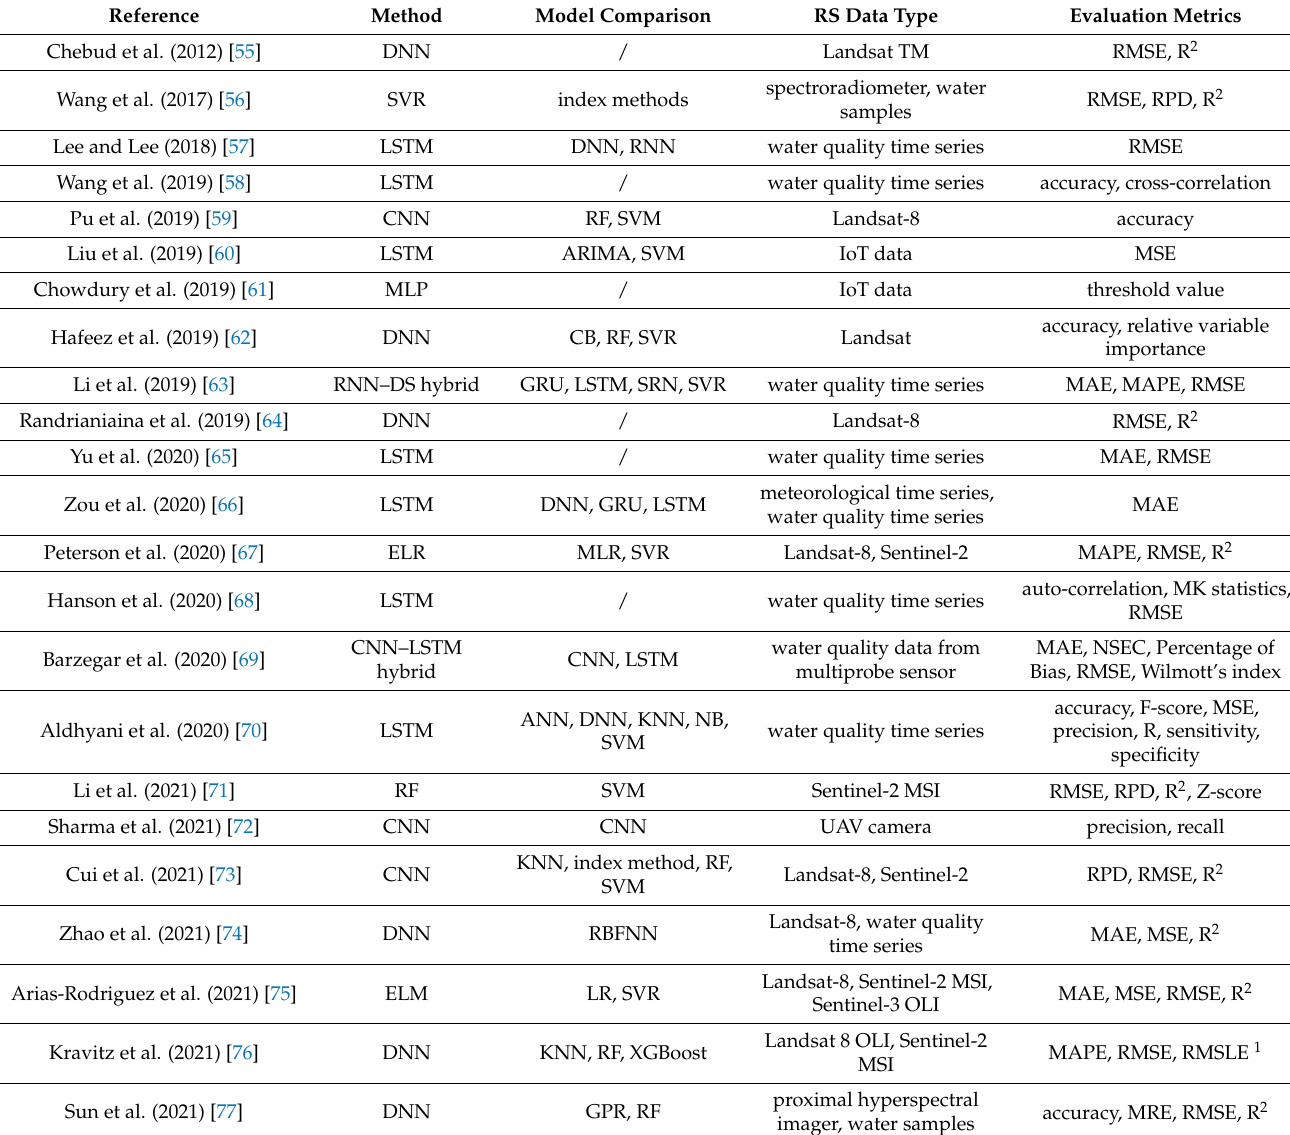
Table 3. Studies targeting water quality monitoring from RS imagery using AI (where “/” means none. Note that it is ordered chronologically to show trends in data type and model usage) (See the Abbreviations for a full list of the